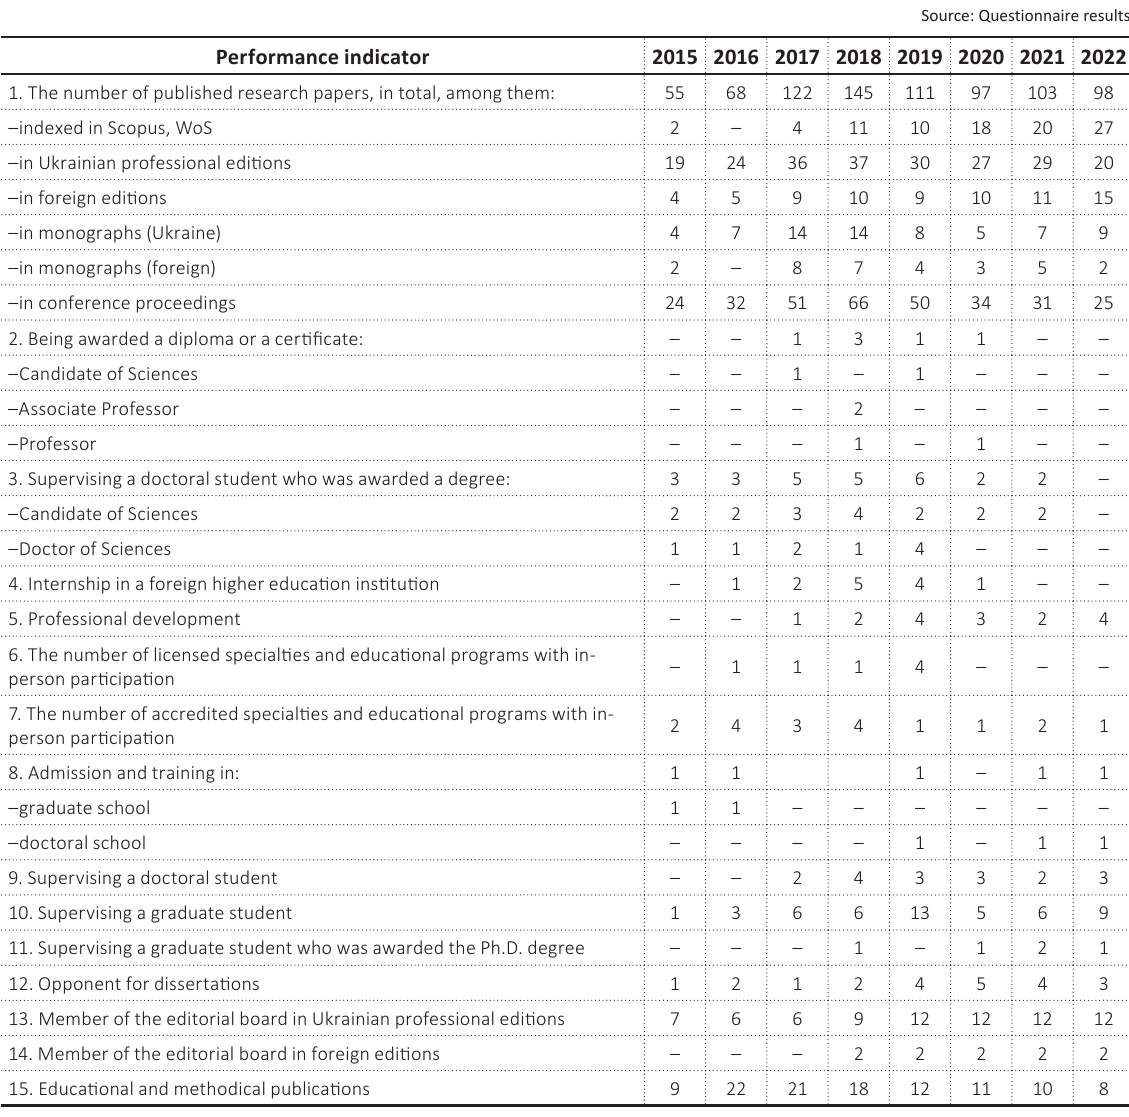
Table 2. Performance of 12 internally displaced teachers employed by Cherkasy State Technological University throughout their direct employment at the university in 2015–2022